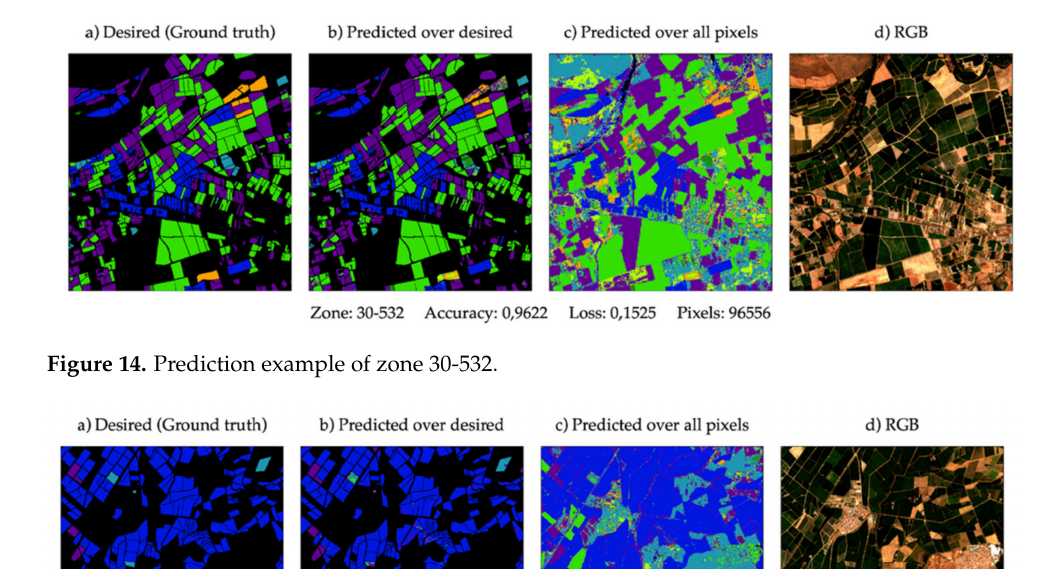
Figure 13. Prediction example of zone 30-581.